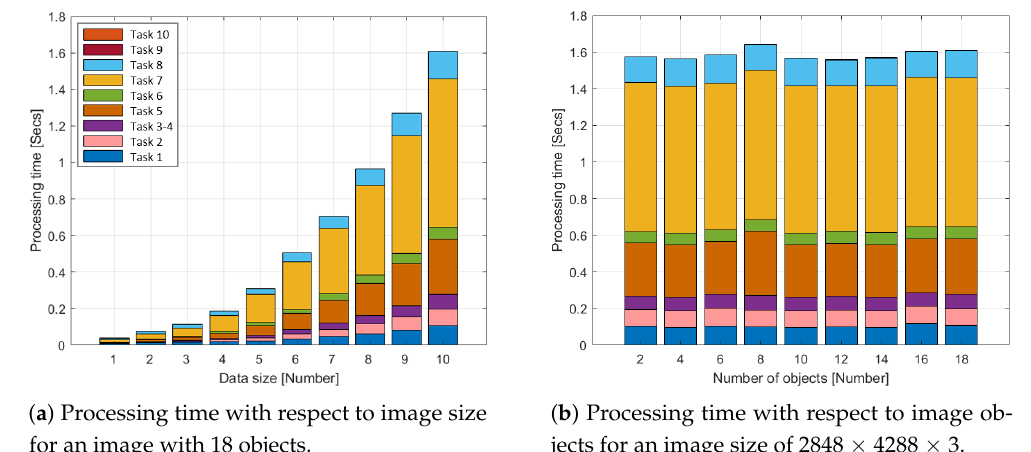
Figure 6. Processing times of tasks from the Raspberry